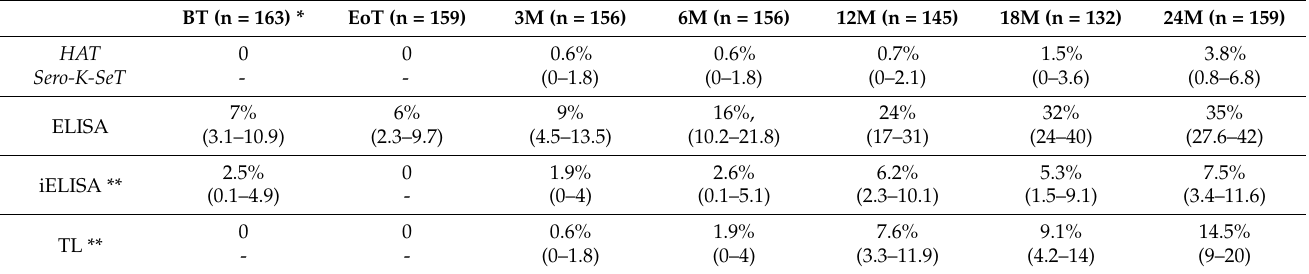
Table 2. Proportion of seronegative results (with 95% CI) by serological test and per follow-up